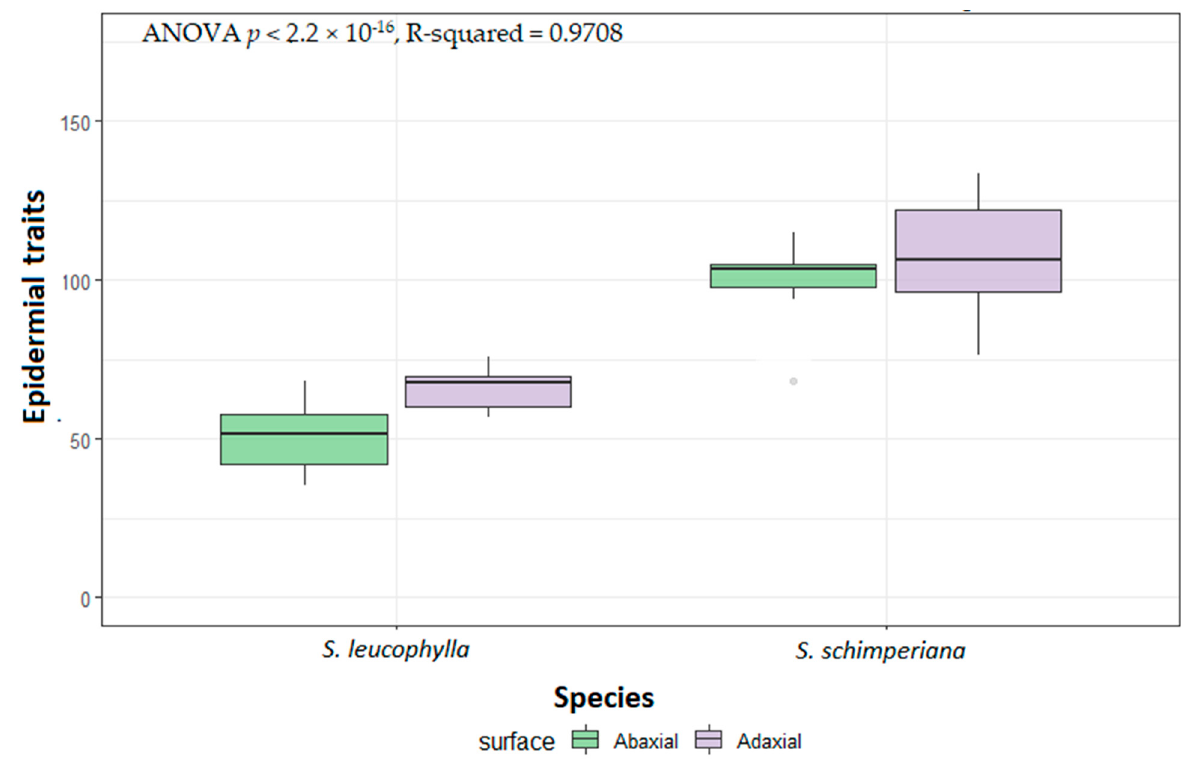
Figure 4. Boxplots of micromorphological quantitative measurements of epidermal cells of Silene leucophylla and Silene schimperiana leaves.